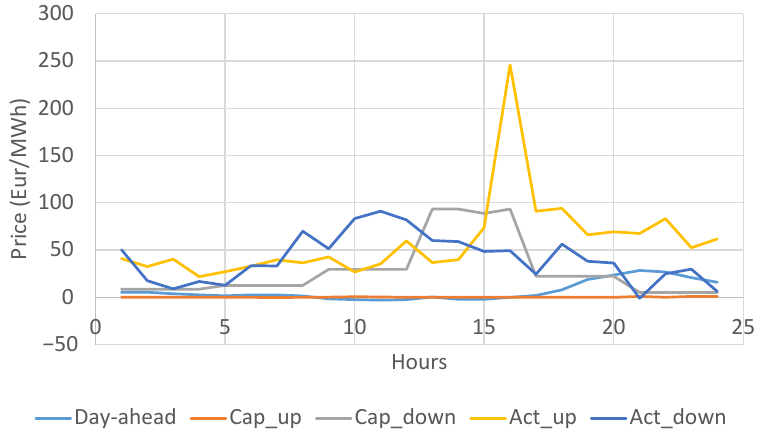
↑ ), up ( λ cap ) and down ( λ cap t t ) activated capacity t , s